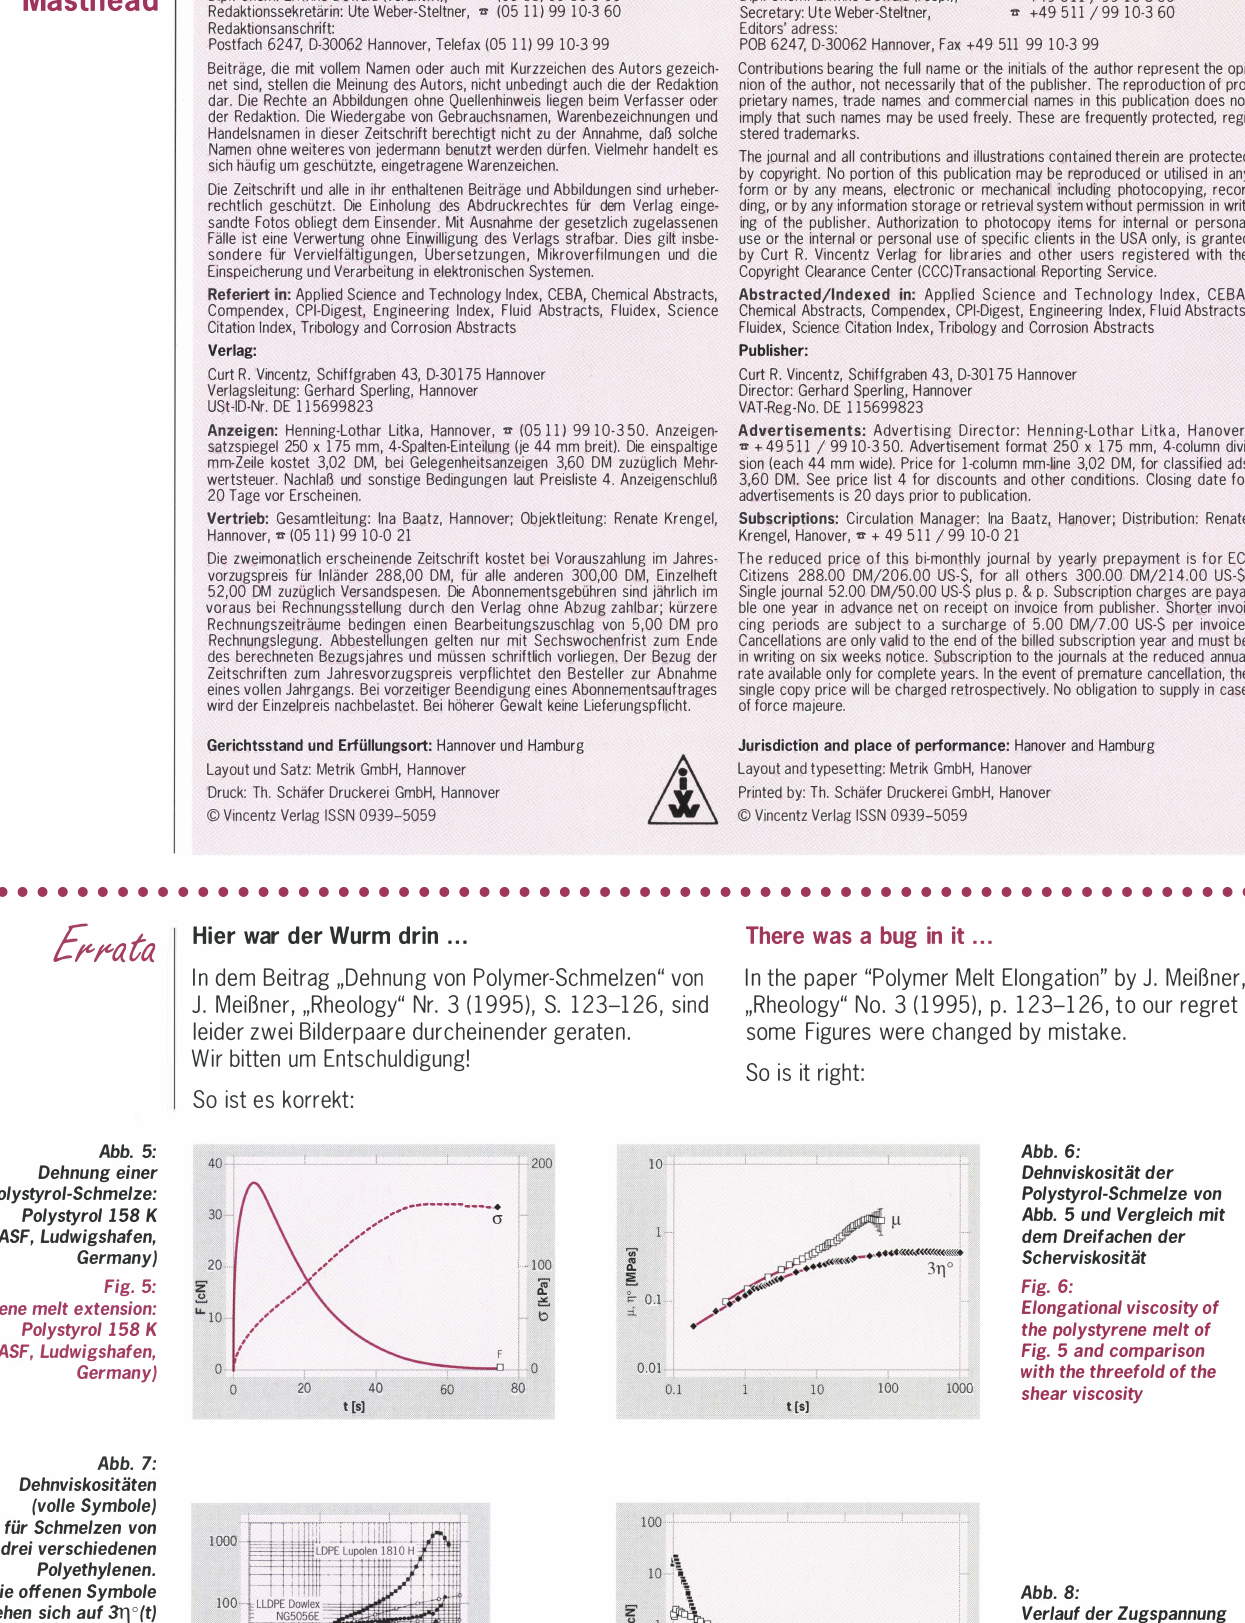
Fig. 7: Elongational viscosities (filled symbols] of three melts of different polyethylenes. The open symbols refer to 3rr (t}